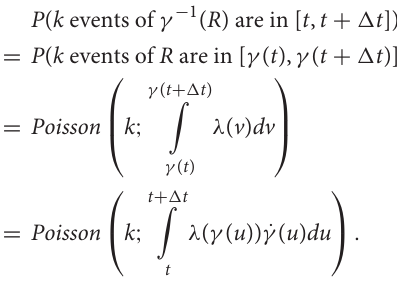
TABLE 1 | Properties of the three group actions.